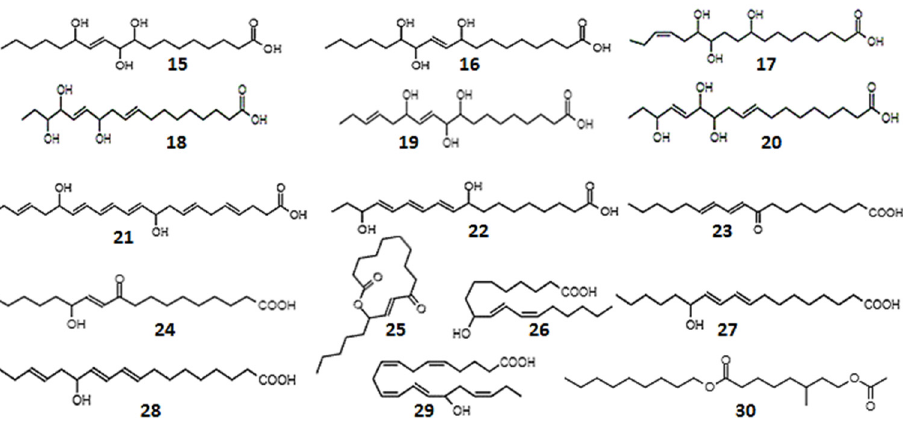
Figure 4. Chemical structures of plant oxylipins, oxy-, hydroxy-, and epoxy-derivatives of fatty acids: 9,10,13-trihydroxy-11-octadecenoic ( 15 ); 9,12,13-trihydroxy-l0-octadecenoic acid ( 16 ); 9,12,13- trihydroxy-15-octadecadienoic ( 17 ); 12,15,16-trihydroxy-9,13-octadecadienoic ( 18 ); 9,10,13-trihydroxy- 11,15-octadecadienoic ( 19 ); 12,13,16-trihydroxy-9,14-octadecadienoic acid ( 20 ); 10,17-dihydroxy- docosahexa-4,7,11,13,15,19-enoic acid ( 21 ); 9,16-dihydroxy-10,12,14-octadecatrienoic acid, isomers ( 22 ); 9-oxo-10,12-octadecadienoic acid ( 23 ); 13-hydroxy-10-oxo-11-octadecenoic acid ( 24 ); 10-oxo- 11-octadecen-13-olide, en-antiomers ( 25 ); 9-hydroxy-10,12-octadecadienoic acid ( 26 ); 13-hydroxy- 9,11-octadecadienoic acid ( 27 ); 13-hydroxyoctadeca-9,11,15-trienoic acid ( 28 ); 15-hydroxyeicosa- 5,8,11,13,17-pentaenoic acid ( 29 ); and nonyl 8-acetoxy-6-methyloctanoate ( 30